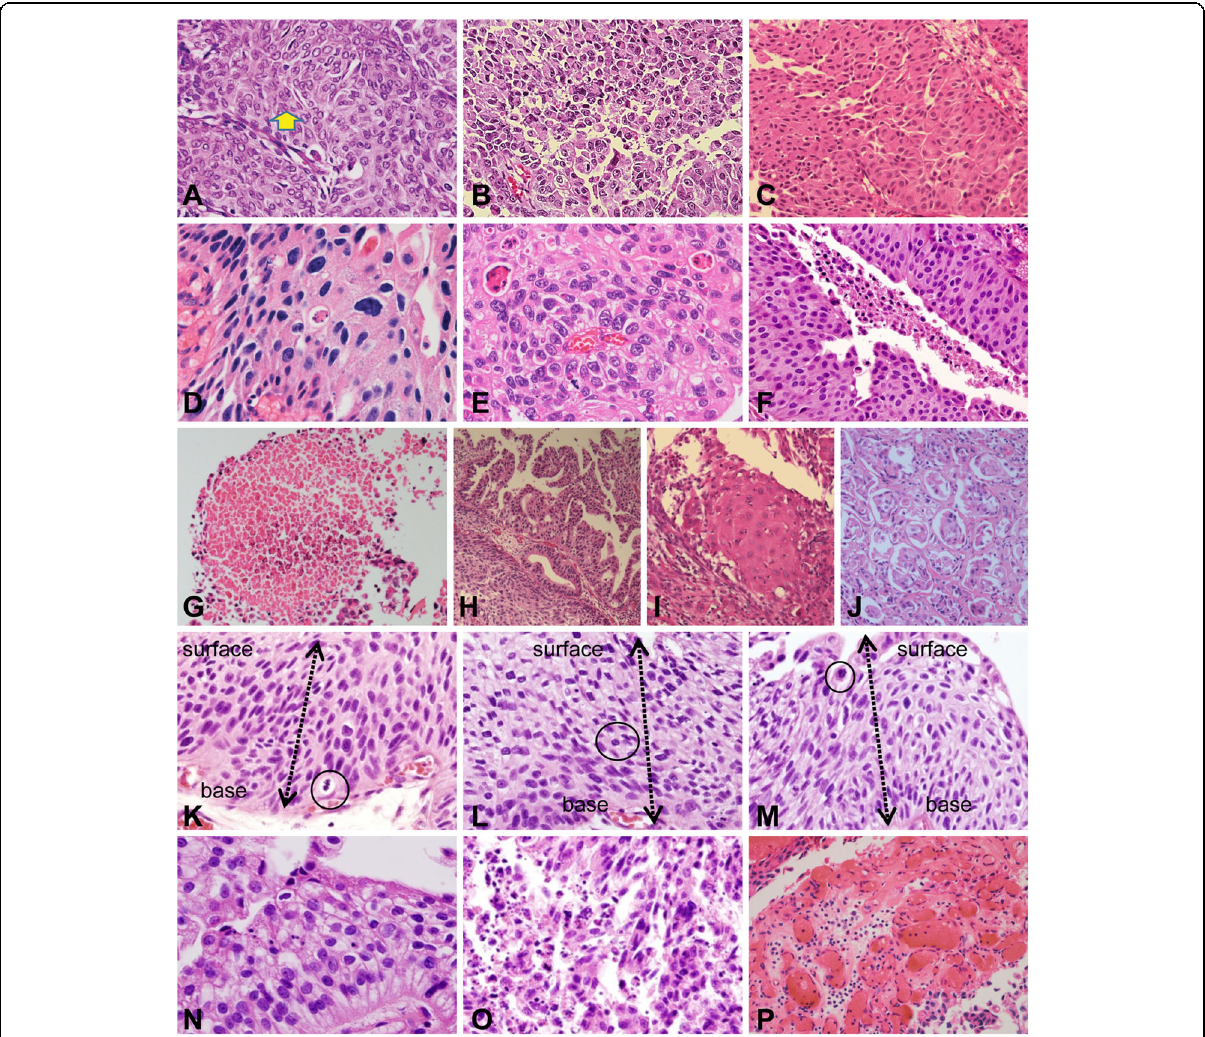
Fig. 2 (2) Further representative images of histological parameters evaluated in this study. a Example of a nuclear groove (arrow). b Prominent nucleoli. c Whorling pattern. d Single spotty necrosis (arrow). e Multifocal group necrosis (arrows). f Surface necrosis. g Confluent necrosis. h Glandular differentiation. i Squamous differentiation. j Micropapillary differentiation. k Mitosis level 1. l Mitosis level 2. m Mitosis level 3. n Apoptosis score 1. o Apoptosis score 3. p Capillary proliferation in fibrovascular core of